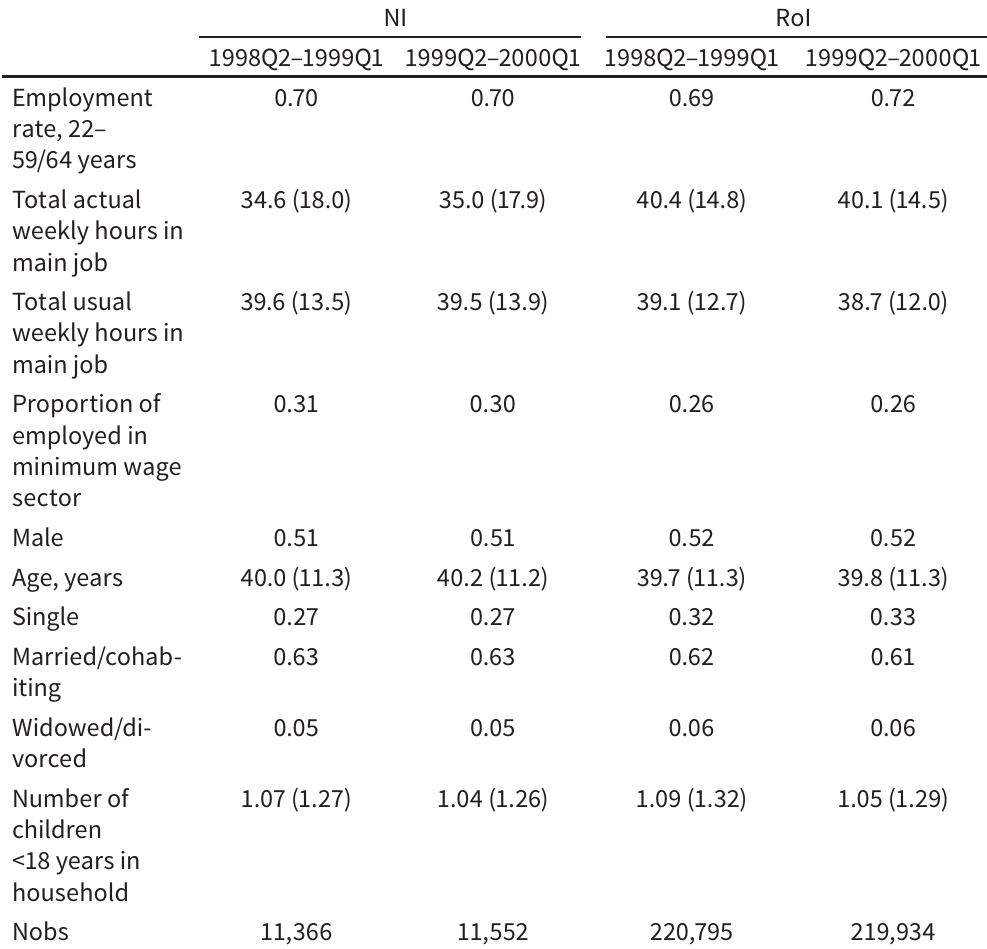
Sample means/proportions (standard deviations) for outcomes and other observable characteristics, NI and RoI, pre and post the introduction of NMW NI RoI 1998Q2–1999Q1 1999Q2–2000Q1 1998Q2–1999Q1